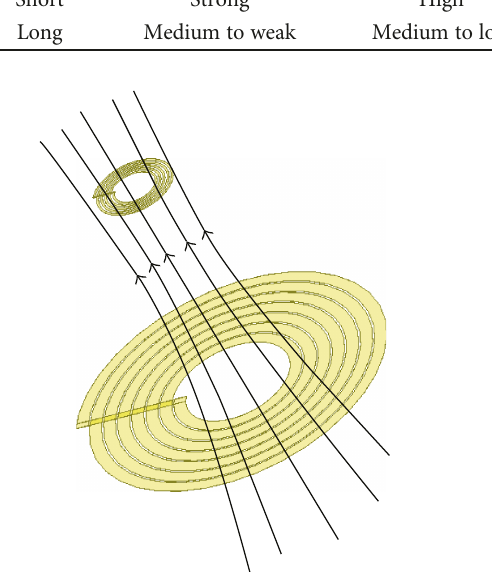
Figure 1: Inductive coupling